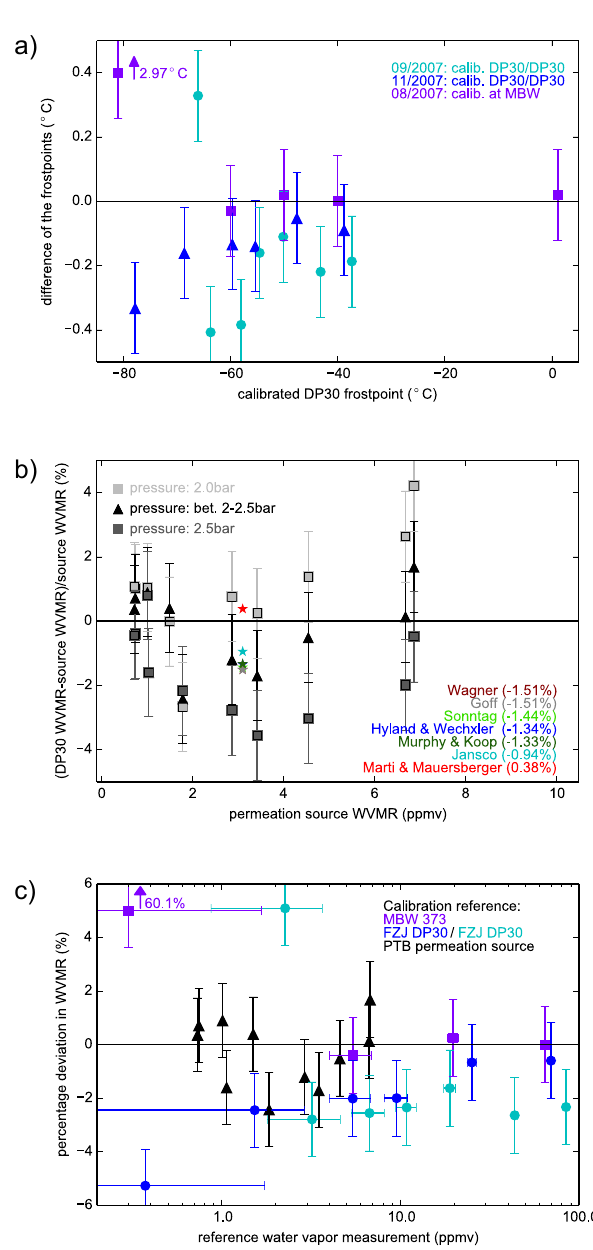
Figure 6. Reference hygrometer calibration: (a) difference of the measured frost points between the first Jülich DP30 frost-point hy- grometer and a MBW reference frost-point hygrometer calibrated to a NPL standard (purple squares) or the second Jülich DP30 (dark blue triangles and light blue dots); (b) relative deviation of the DP30 WVMR measurement to the WVMR given by the per- meation source (PTB, traceable to primary standard) for different pre-pressure levels and comparison of different saturation equilib- rium approximations applied to the measured frost points (stars); (c) combination of the measurements of (a) and (b)